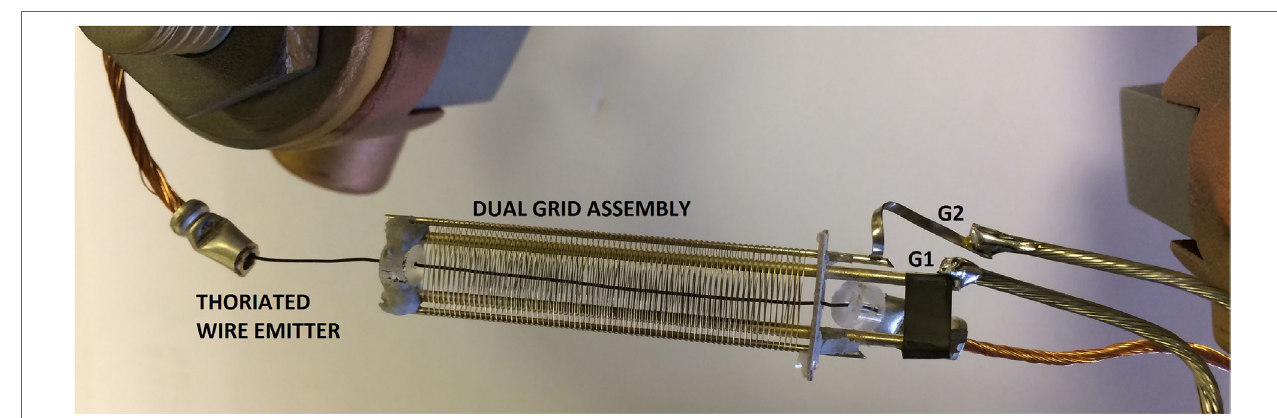
FigUre 3 | Photograph of the Mk II dual-grid thermionic energy convertor assembly illustrating the cylindrical construction of the commercial grids in a vacuum demountable device, inter-electrode distance approximately 1 cm, thoriated wire emitter, and nickel collector.